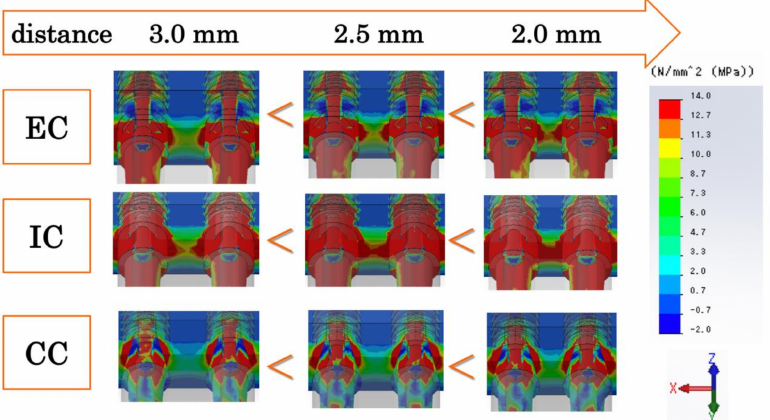
Figure 5. Maximum principal stress distribution of the bone and implant model at the three assessed inter-implant distances. The < and > signs indicate the relationships between models regarding the magnitude of the range of the stress distribution. EC: external connection; IC: internal connection; CC: conical connection.